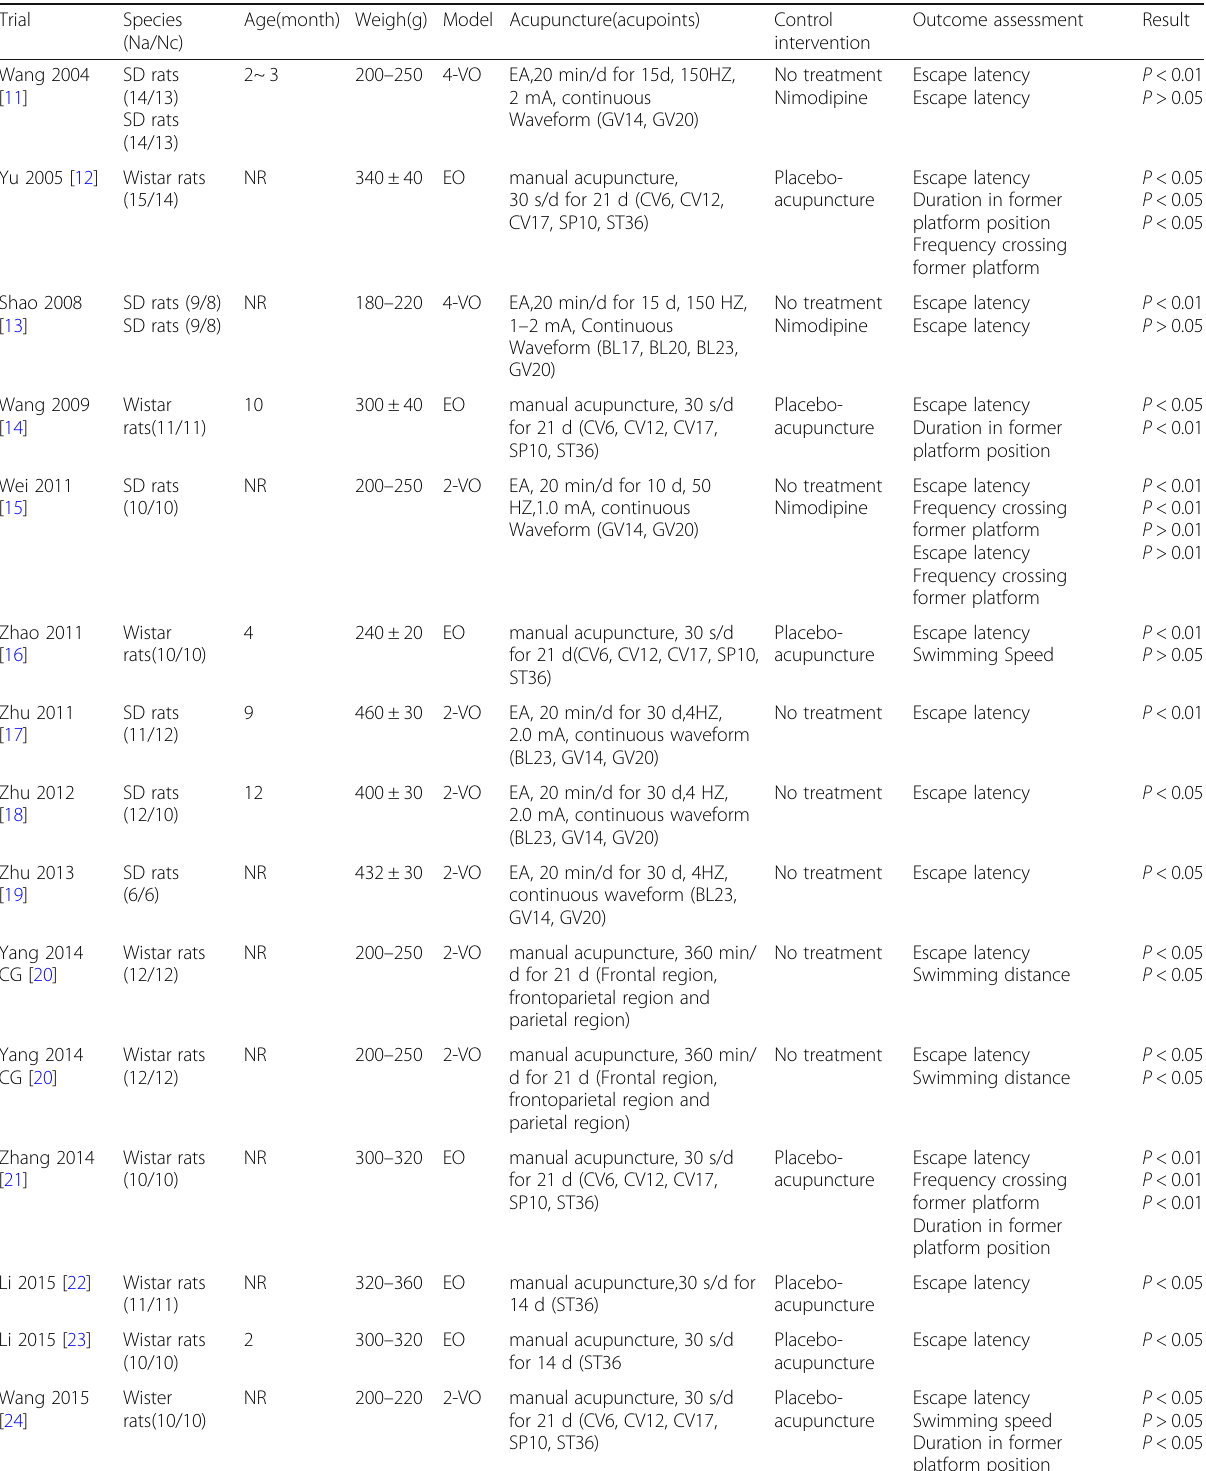
Table 1 Data of 16 included